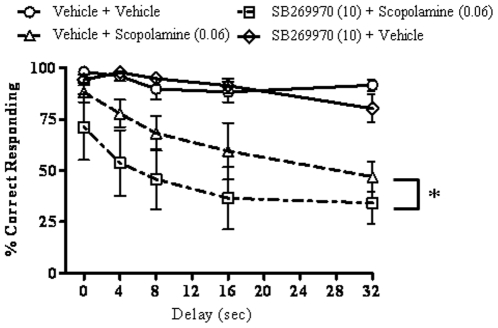
Effects of SB-269970 on scopolamine-induced DNMTP deficits.SB-269970 (10 mg/kg) and scopolamine (0.06 mg/kg), or their vehicles, were administered 10 and 30 min, respectively, before the beginning of the session (N = 6 per group). SB-269970 augmented the deficit caused by scopolamine (*p<0.05, main effect). For statistical details see the result section.